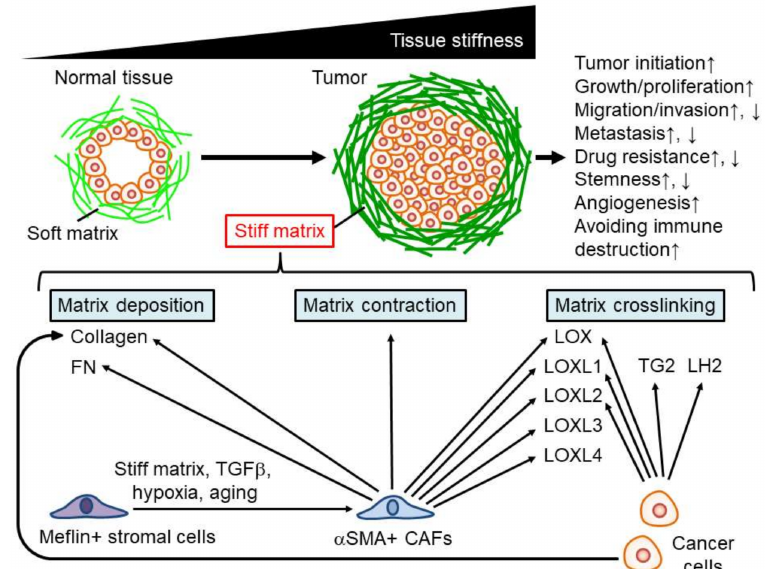
Figure 1. Mechanisms of cancer stiffening and contribution of matrix stiffness to cancer progression. ↑ : upregulation, ↓ :